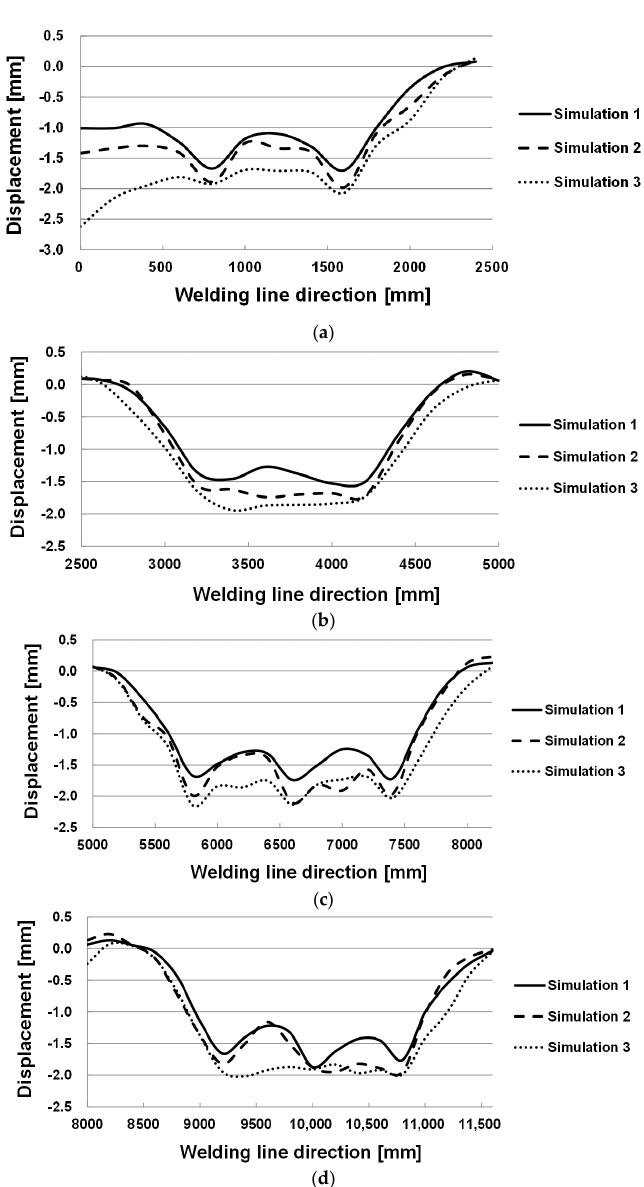
Figure 22. Simulation results (displacement in welding line direction x=0 mm): ( a ) zone I; ( b ) zone II; ( c ) zone III; and ( d ) zone IV.